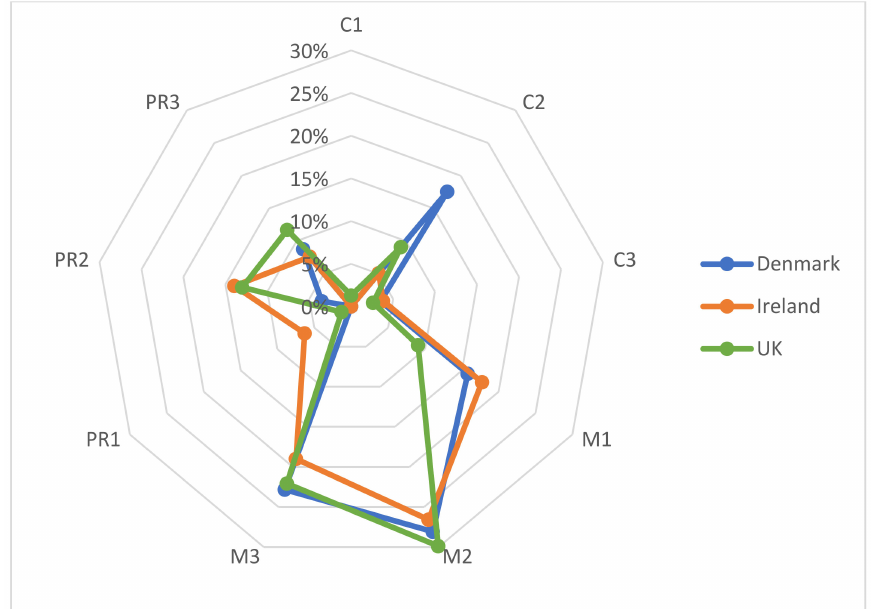
Figure 3. Representation of the focus in terms of scale and dimensions of social acceptance of RE in the NREAP policies of Denmark, Ireland, and the